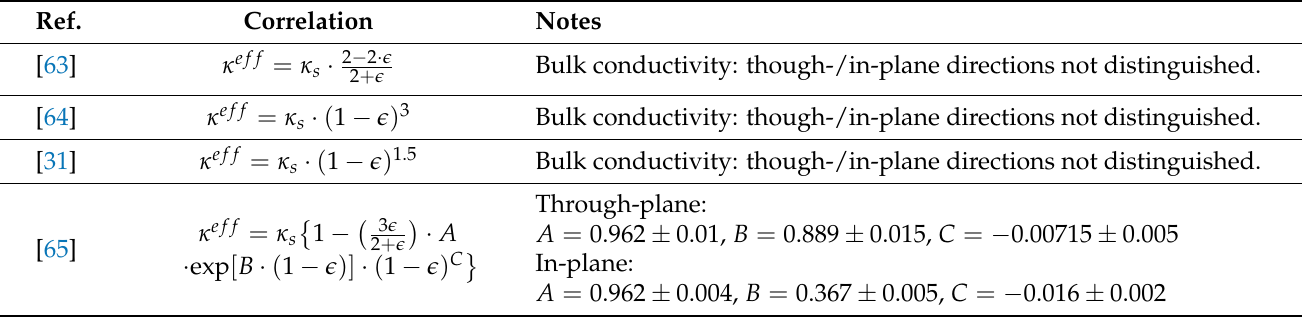
Table 7. Correlations for GDL electrical conductivity κ ef f [S/m].